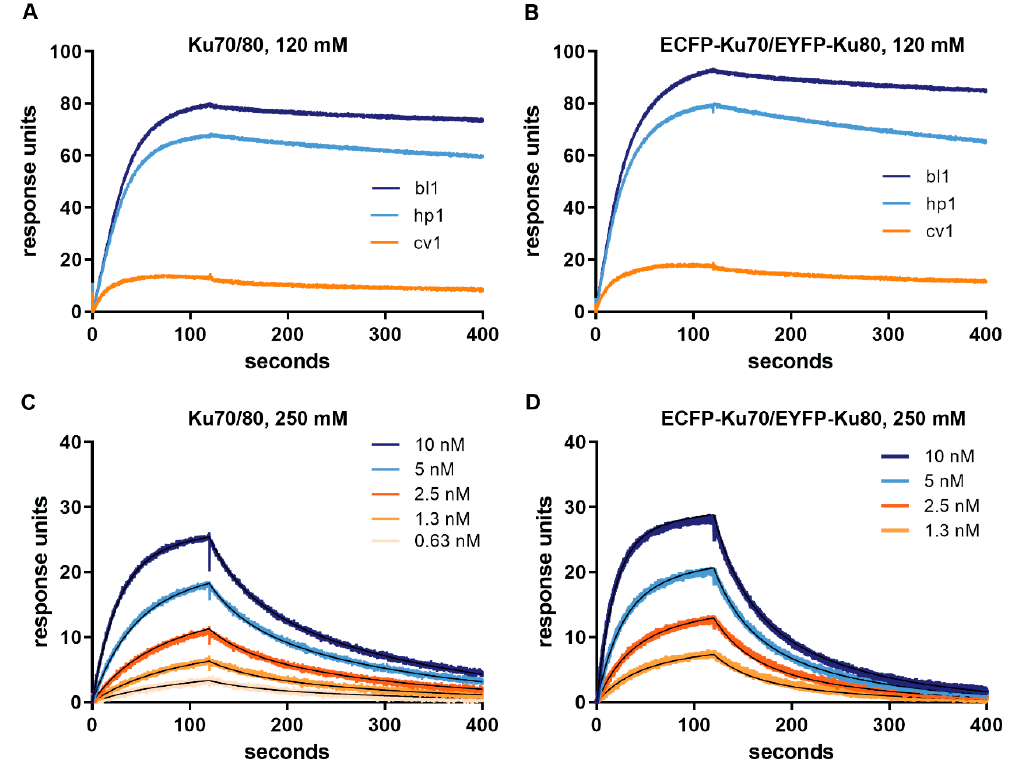
Figure 3. SPR (surface plasmon resonance) analysis of untagged Ku and ECFP-Ku70 / EYFP-Ku80 binding to DNA. ( A ) Sensorgram of 10 nM Ku70 / 80 binding to blunt (bl1), hairpin (hp1), and clover-leaf (cv1) DNA at 120 mM NaCl. ( B ) Sensorgram of 10 nM ECFP-Ku70 / EYFP-Ku80 binding to bl1, hp1, and cv1 DNA at 120 mM NaCl. ( C ) Sensorgram of Ku70 / Ku80 (0.625–10 nM) binding to bl1 DNA at 250 mM NaCl. ( D ) Sensorgram of ECFP-Ku70 / EYFP-Ku80 (1.25–10 nM) binding to bl1 at 250 mM NaCl. The fit of the model is indicated with thin black lines.